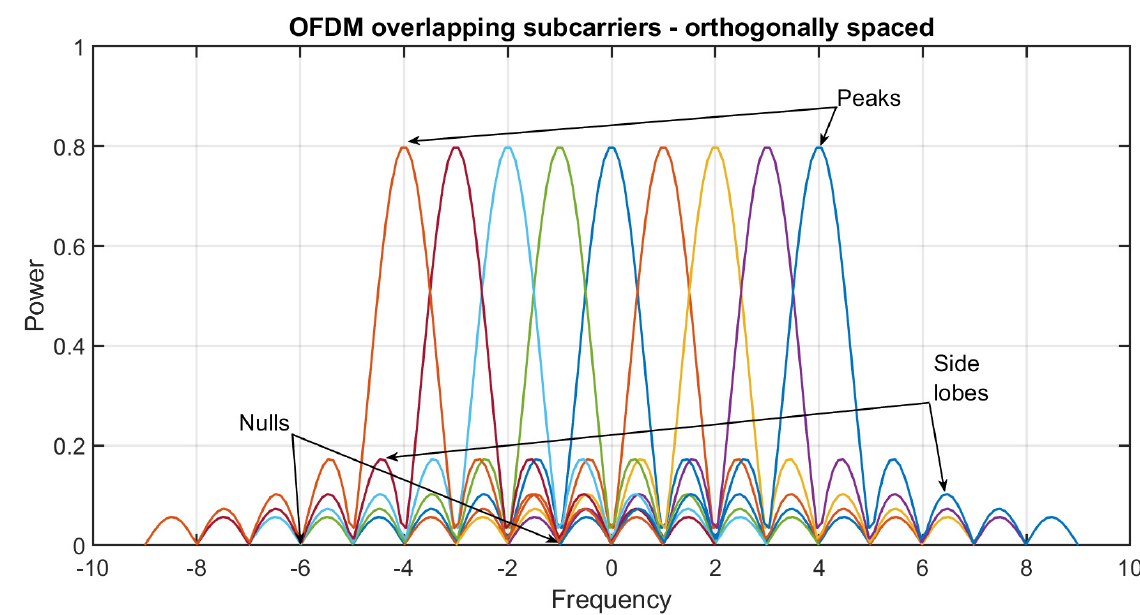
Figure 5. Concept of orthogonality.